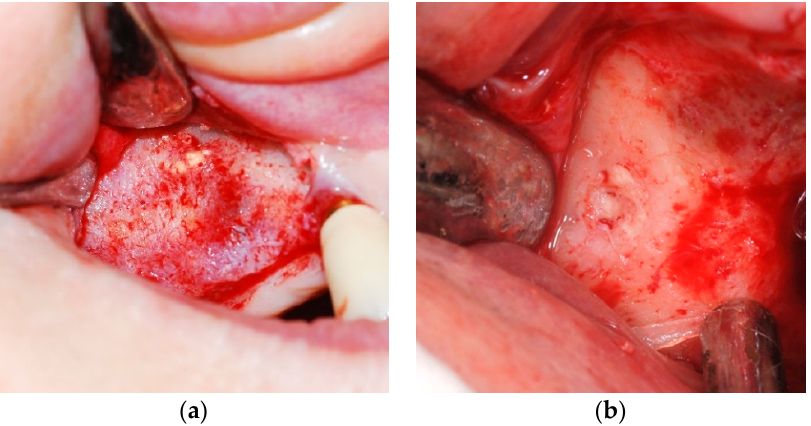
Figure 5. ( a ) Healing state of a minimum-sized lateral window at 5 months after the surgery. Without utilizing barrier membrane, particles of anorganic bovine bone could be observed on bone surface and periosteum; ( b ) Healing state of a minimum-sized lateral window without utilizing barrier membrane at 48 months after the surgery (anorganic bovine bone graft).